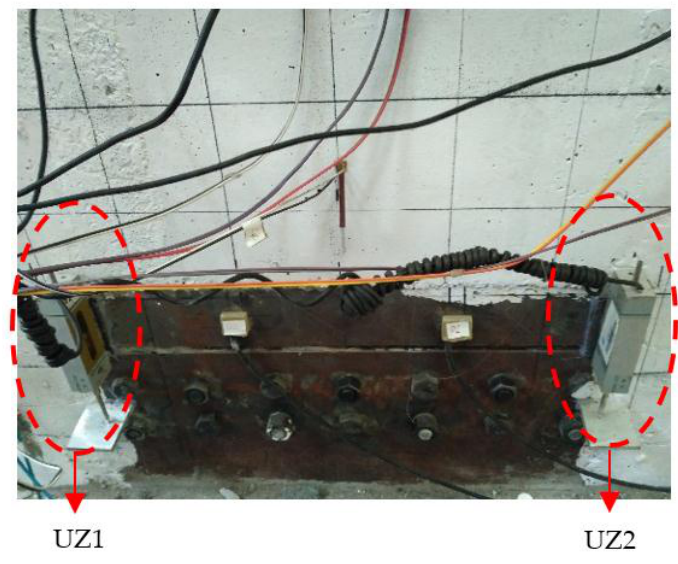
Figure 5. Arrangement of displacement transducers.